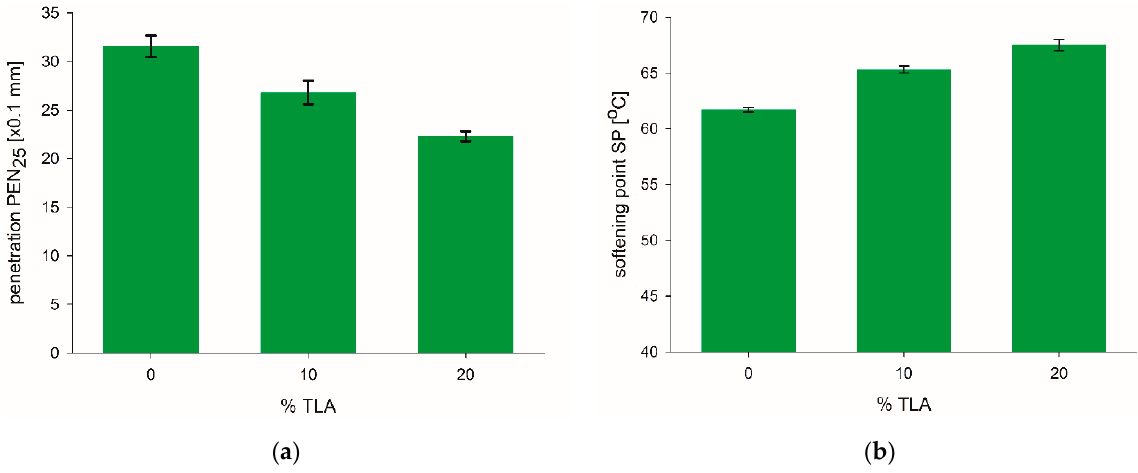
Figure 2. ( a ) Penetration and ( b ) softening point after RTFOT ageing of TLA-modified binders with different TLA content.